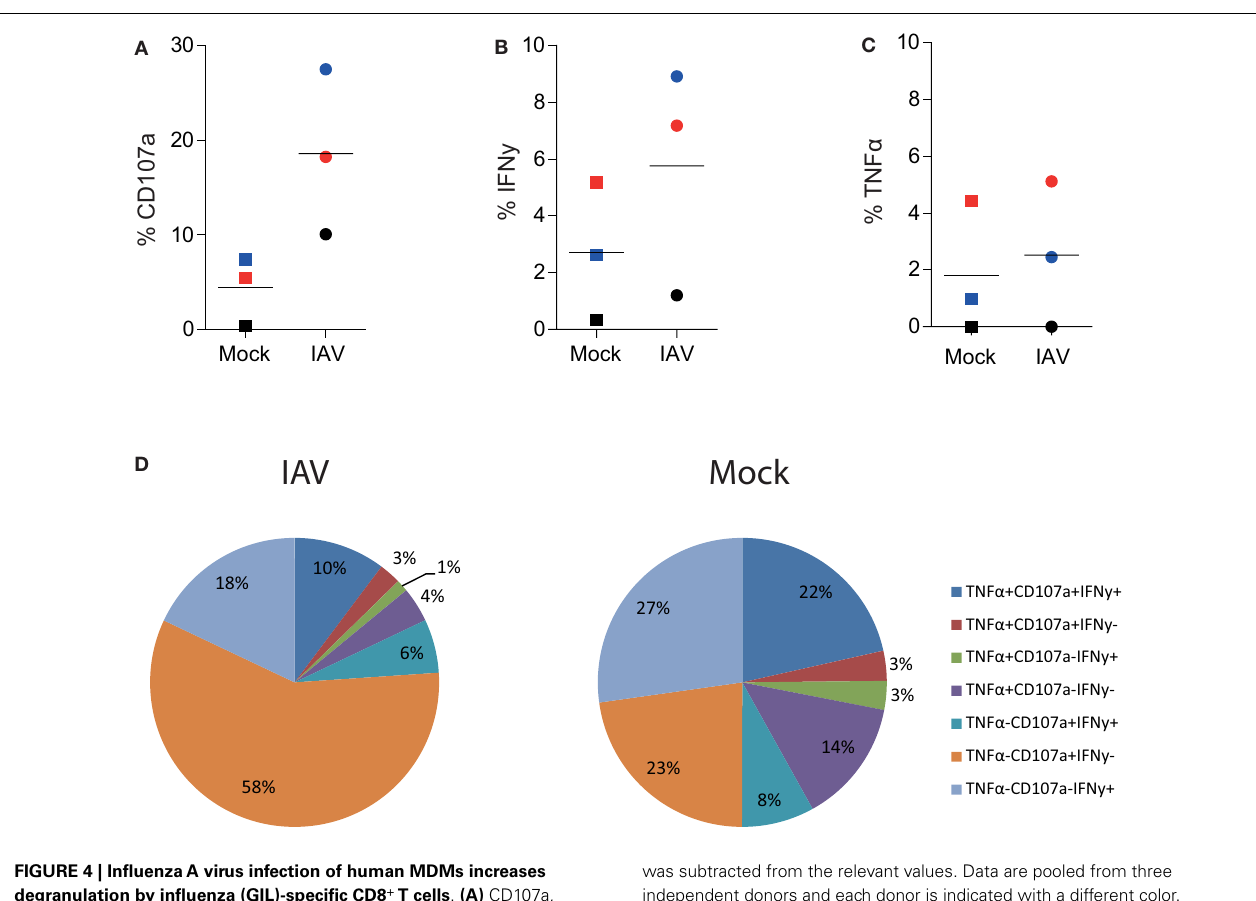
FIGURE 4 | InfluenzaA virus infection of human MDMs increases degranulation by influenza (GIL)-specific CD8 + T cells . (A) CD107a, (B) IFN- γ , or (C) TNF- α expression by single-cell, CD3 + CD8 + T cells following 6h co-incubation with IAV- or mock-infected M1-pulsed MDMs.The percentage of positive cells detected following co-incubation with mock-infected macrophages pulsed with 10 µ L DMSO (instead of peptide)